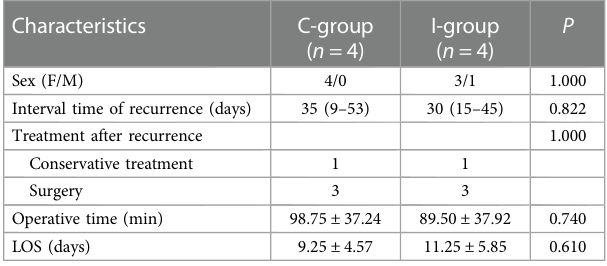
TABLE 3 Outcomes of patients who showed recurrence for the control group and intervention group after treatment. Characteristics